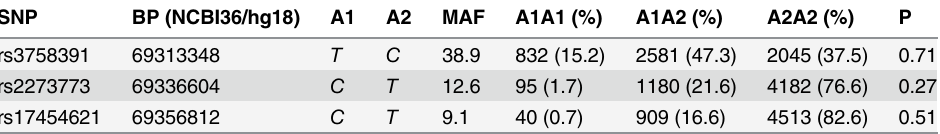
Table 2. SIRT1 genotype counts and frequencies and Hardy-Weinberg equilibrium p-values. BP; Base pair position. A1; Minor allele. A2; Major allele. MAF; Minor allele frequency. A1A1, A1A2, A2A2; Genotype counts and frequencies (%). P; Hardy-Weinberg